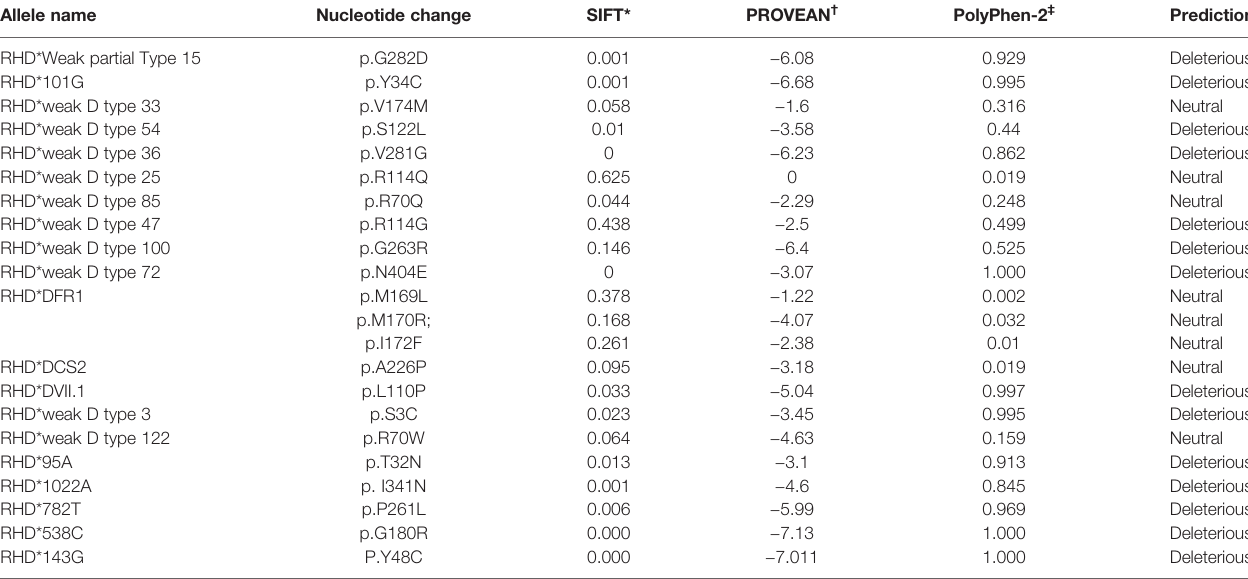
TABLE 4 | Predicted effect on RhD protein structure based on nucleotide variation in silico using different tools.